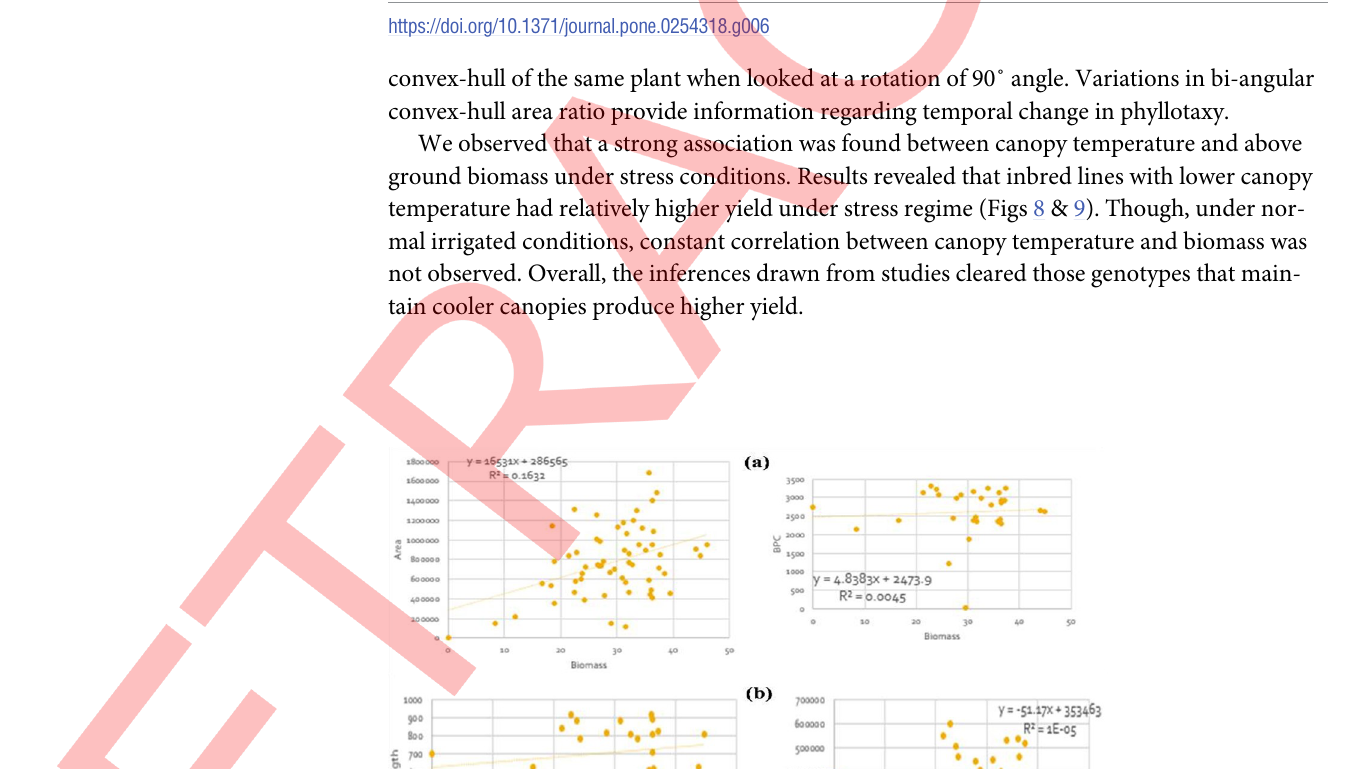
Fig 6. Top ranking bi-convex hull ratio lines in control and stressed pots.